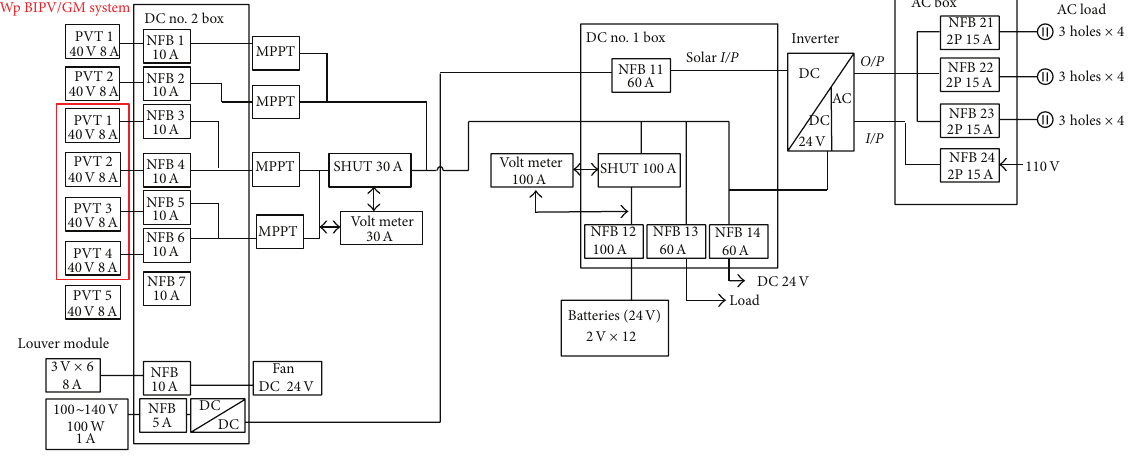
Figure 6: The electrical-circuit layout of the 1kWp BIPV/GM system.